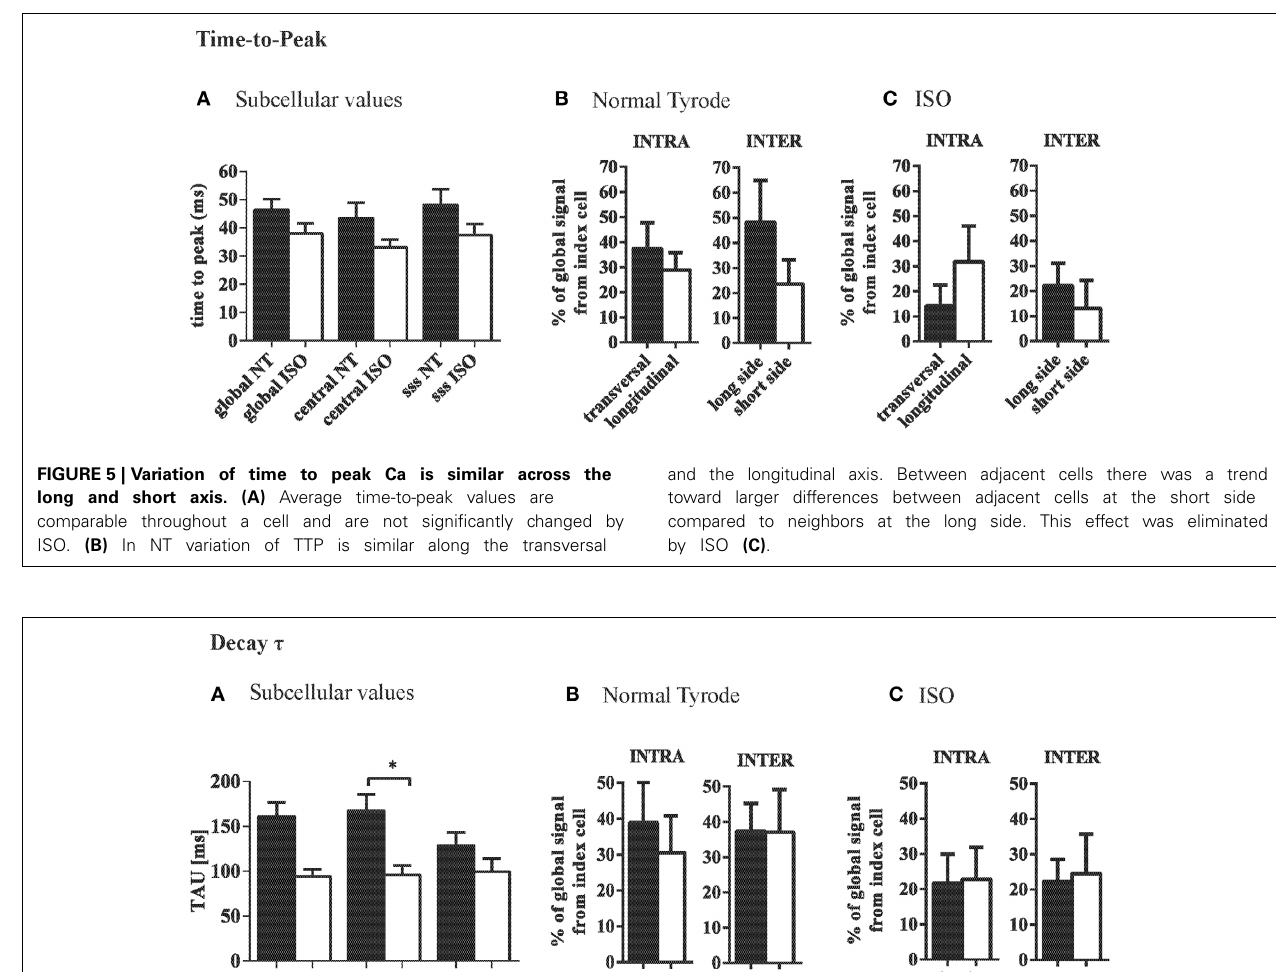
was not depending on the orientation of the ROIs within or between neighboring cells. (C) ISO tended to increase the variation in tau but did not change the pattern found in NT. ∗ p ≤ 0 . 05